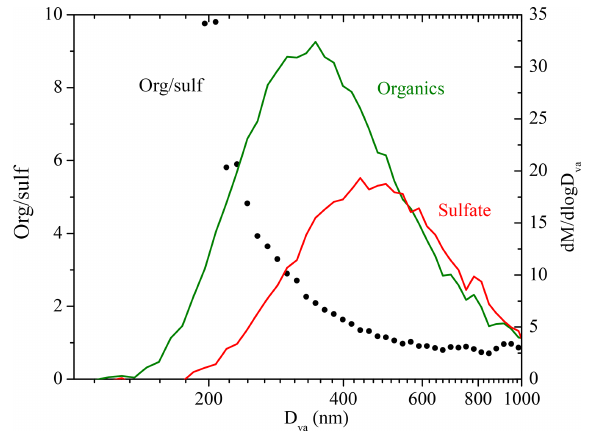
Figure 7. The dependence of the AMS-derived organic-to-sulfate ratio on particle vacuum aerodynamic diameter for Exp. 1 (left axis). Also shown are the AMS-measured organic (green) and sul- fate (red) mass distribution (right axis). The results are based on PToF data averaged over ∼ 2.5h ( t = 1.1 to